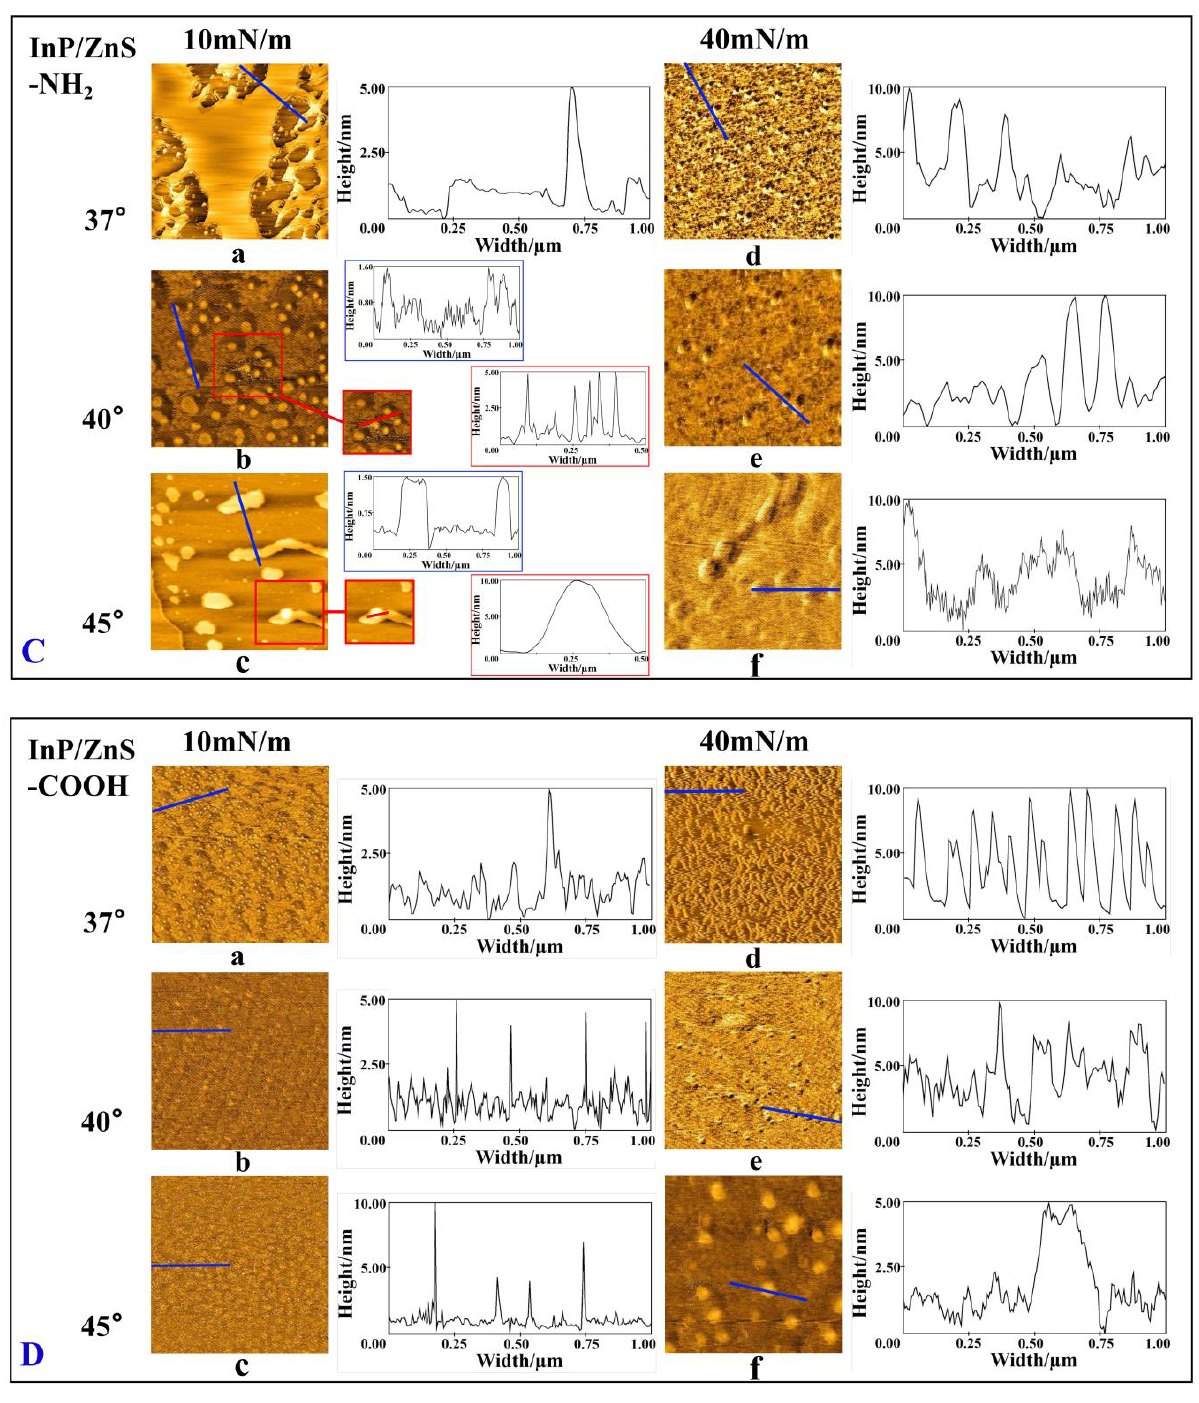
Figure 4. The morphology and height of the DPPC/DPPG mixed monolayer on the micas in the absence of QDs ( A ) and in the presence of InP/ZnS ( B ), InP/ZnS-NH 2 ( C ) and InP/ZnS-COOH QDs ( D ) studied by atomic force microscope.